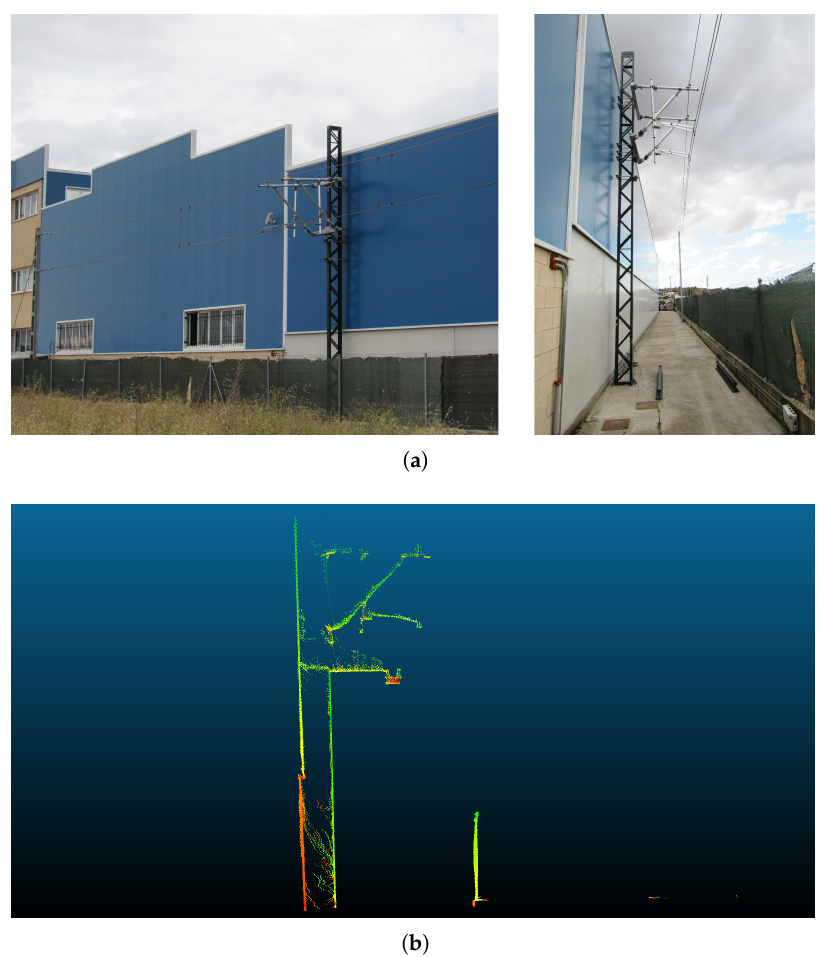
Figure 8. Test bench environment in which test bench data was collected. ( a ): picture from test bench environment; ( b ): point cloud recorded in test bench